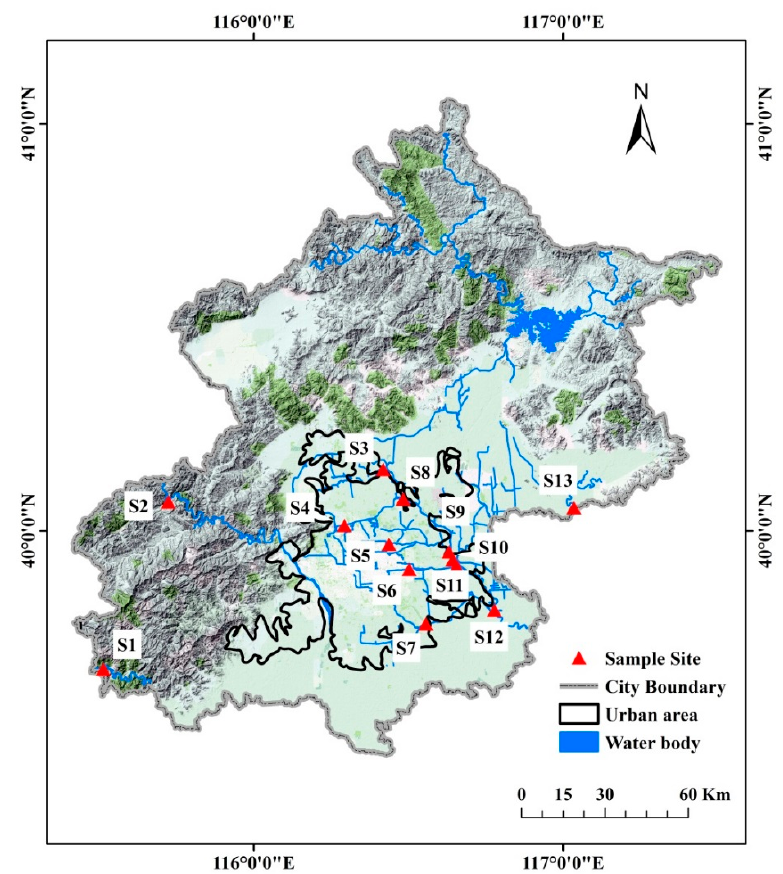
Figure 1. The spatial distribution of the 13 sample sites, overlapping on the topographic map of Beijing (from Google map, 20 July 2015).